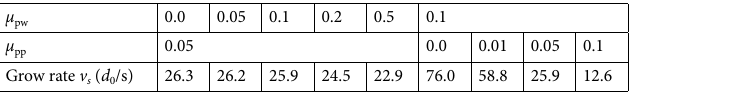
Table 1. Growth rate of the shell v s . Here λ =